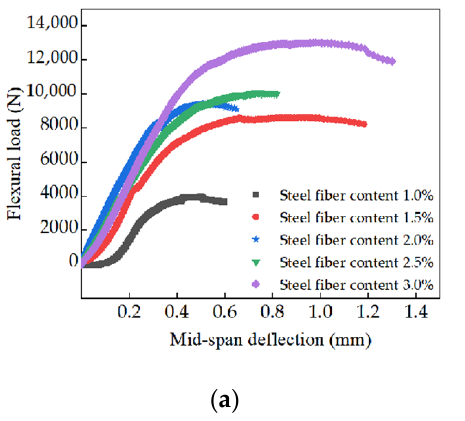
Figure 10. The load-mid-span deflection curves and the corresponding fitting results. ( a ) Load-mid-span deflection curves. ( b ) The fitting results load-mid-span deflection curves. Table 4. The fitting results of the relationship between the flexural load and the mid-span deflection.